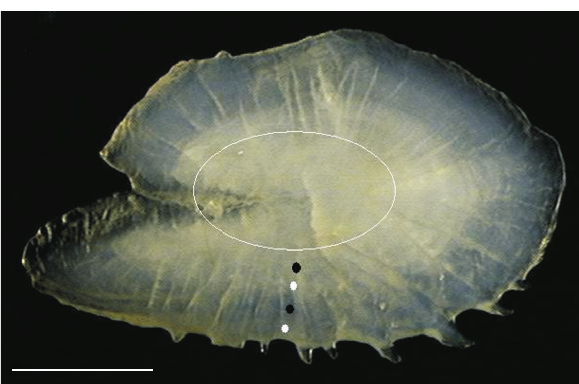
circle: opaque central area, black circles: translucent marks, and white circles: opaque marks. Scale bar: 1 mm.